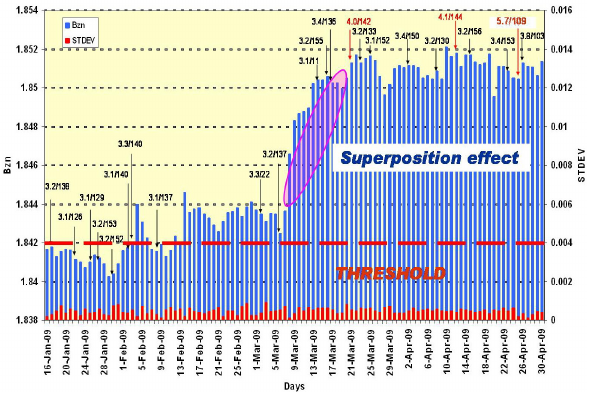
Fig. 5 Fig. 5. Bzn and STDEV distributions at the GOPS, within the in- terval 16 January–30 April 2009; vertical arrows are earthquakes and ratio 5.7/109 is the magnitude/hypocentre depth of earthquake; dashed red line is threshold.